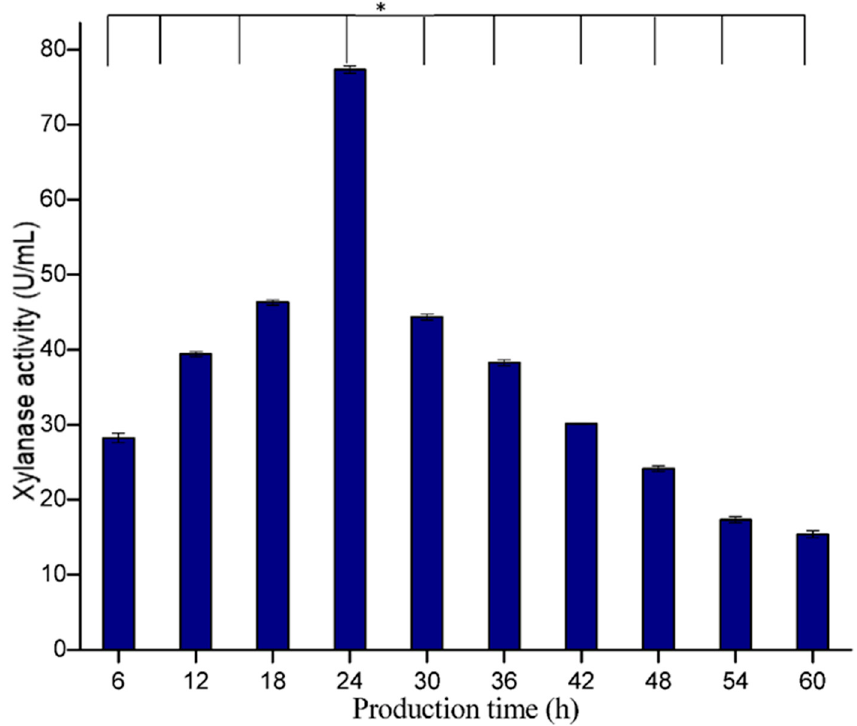
Figure 11. Time course of xylanase production by B. safensis XPS7 (Medium: M5; temp.: 45 °C; time: 6 to 60 h; pH: 9; inoculum: 4%). All the experiments were performed in triplicate. Bars display mean ± SD and statistical analysis was performed using a one-way ANOVA with a Tukey post hoc test, with p < 0.01 *.